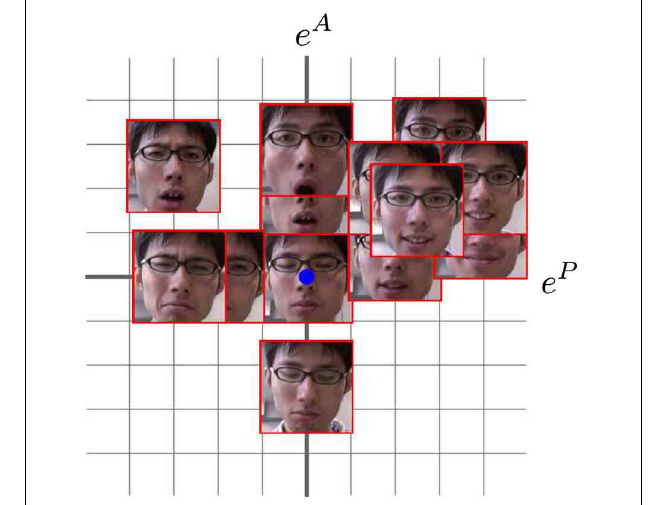
FIGURE 3 | Facial expressions and appealing behavior of the virtual agent. (A) Calm, (B) laugh, (C) surprise, (D) cry, and (E) appealing. FIGURE 4 | Learned map of facial images and emotional